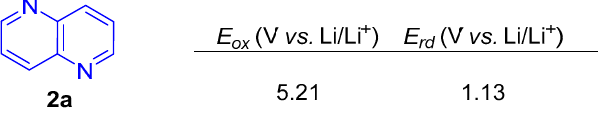
Figure 44. Additives in lithium-ion batteries.